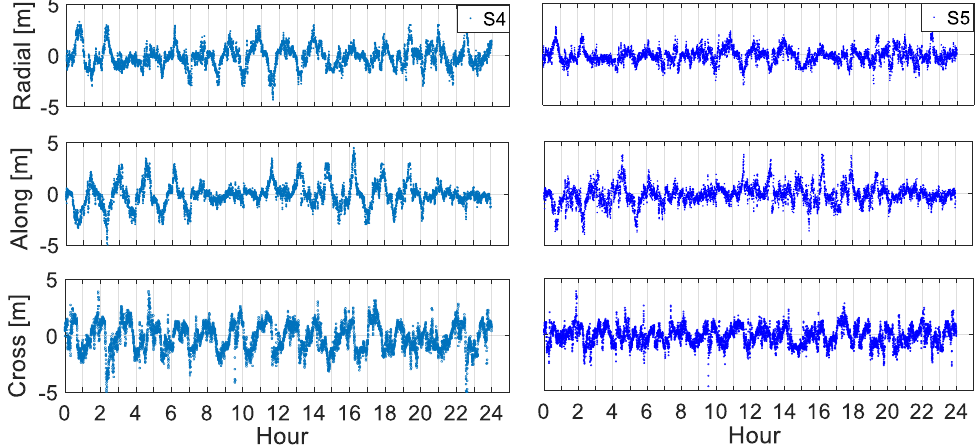
Figure 7. Swarm-A real-time POD results of Schemes 4 ( left ) and 5 ( right ).